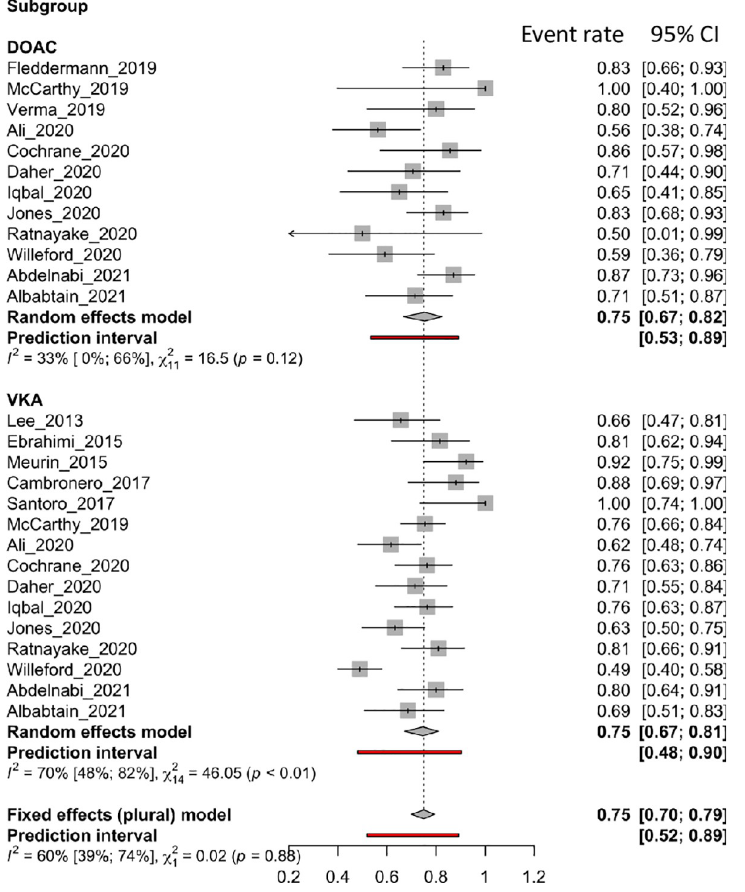
Fig 2. Forest plot of the proportion of left ventricular thrombus resolution rate for DOACs and VKAs therapy. resolution between the two groups (VKAs: 0.75 [95% CI: 0.67 to 0.81]; DOACs: 0.75 [0.67 to